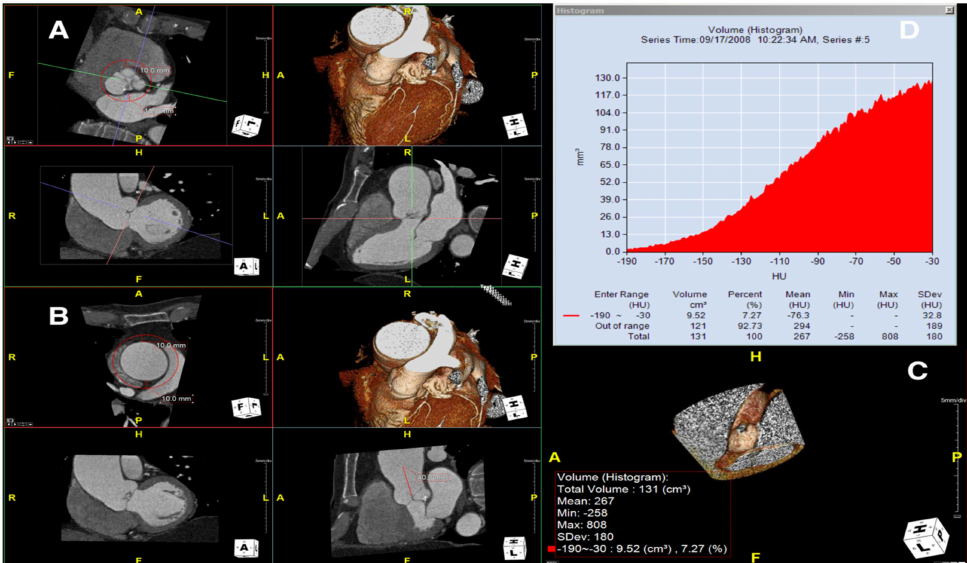
Figure 1. Step-by step process used to measure peri-aortic adipose tissue attenuation at Computed Tomography imaging. After spatial planes reorientation along the long and short axis of the ascending aorta, a 2D circle using an incremental +10 mm radius beyond the aortic diameter at the cusps level is traced ( A ) and a second circle is then drawn 40 mm distally, using in this case the diameter of the aorta at that level ( B ). The software automatically interpolates the volume between the two circles and builds the 3D volume sample ( C ), whose volume is known (131 cm 3 in this case). The software also calculates the volume corresponding to a pre-determined Hounsfield Unit range; for fat sampling we used a − 190 to − 30 Hounsfield units (HU) range (in this case a volume of 9.52 cm 3 is automatically measured). Panel ( D ) (fat attenuation histogram) shows that the mean attenuation of fat found in this custom sample volume shown in panel C is − 76.3 HU.